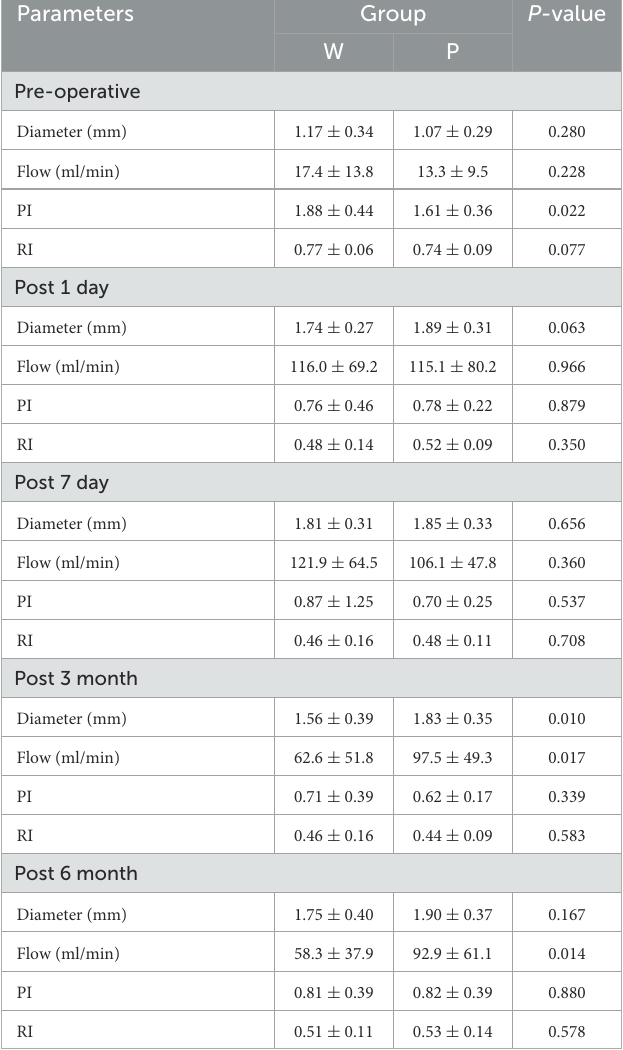
TABLE 2 Comparisons of the ultrasonic hemodynamic indicators in different time point of the well-compensated collateral group (W group) and poorly-compensated collateral group (P